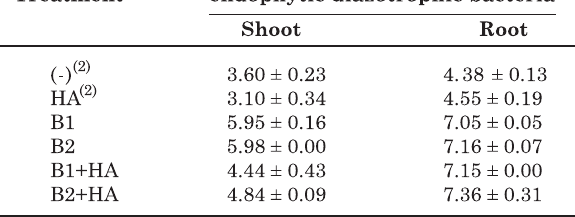
Table 4. Most Probable Number (log) of endophytic diazotrophic bacteria present in shoot and root of ‘Vitória’ pineapple plants in response to the application of humic acid and plant growth- promoting bacteria during acclimatization